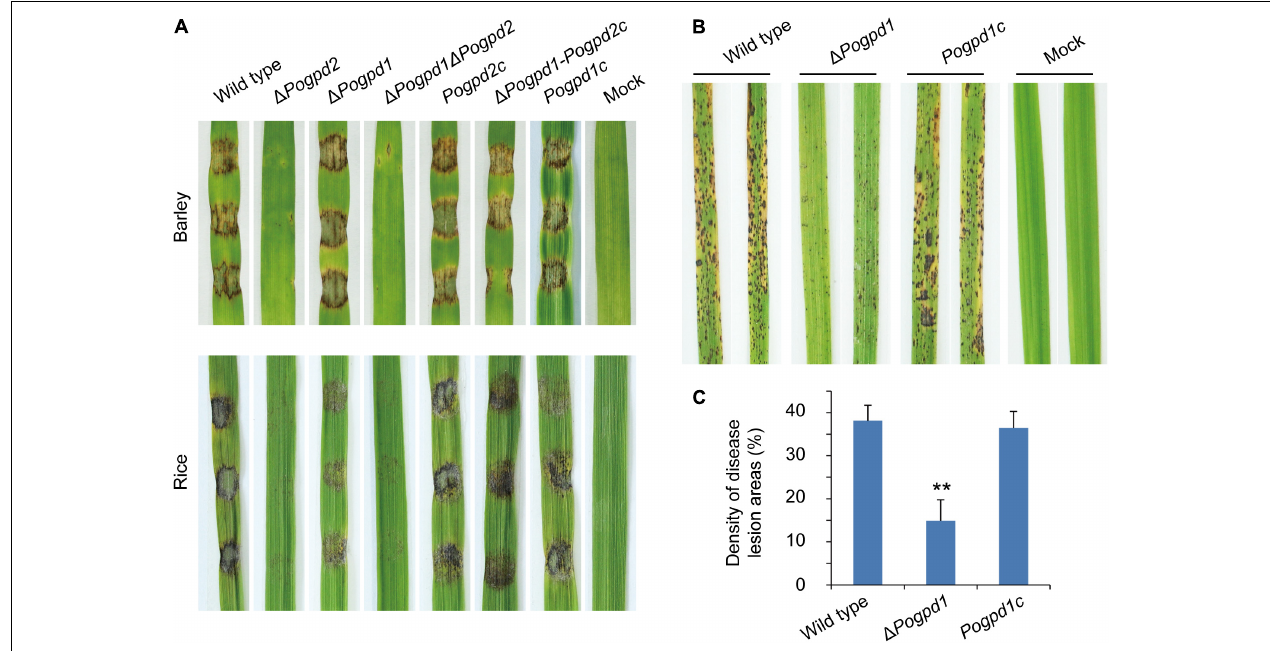
FIGURE 10 | Roles of glycerol-3-phosphate dehydrogenases on fungal virulence in Pyricularia oryzae . (A) Pathogenicity assays on excised-leaf of rice and barley inoculated with mycelial plugs. (B) Pathogenicity assays on rice seedling sprayed with conidial suspension. (C) Disease lesion severity assays for tests in (B) . Proportion of lesion areas in 5-cm-length leaves (%) was counted. Error bars represent SD. Significant difference compared with the wild type as estimated by Tukey’s HSD test: ∗∗ P <